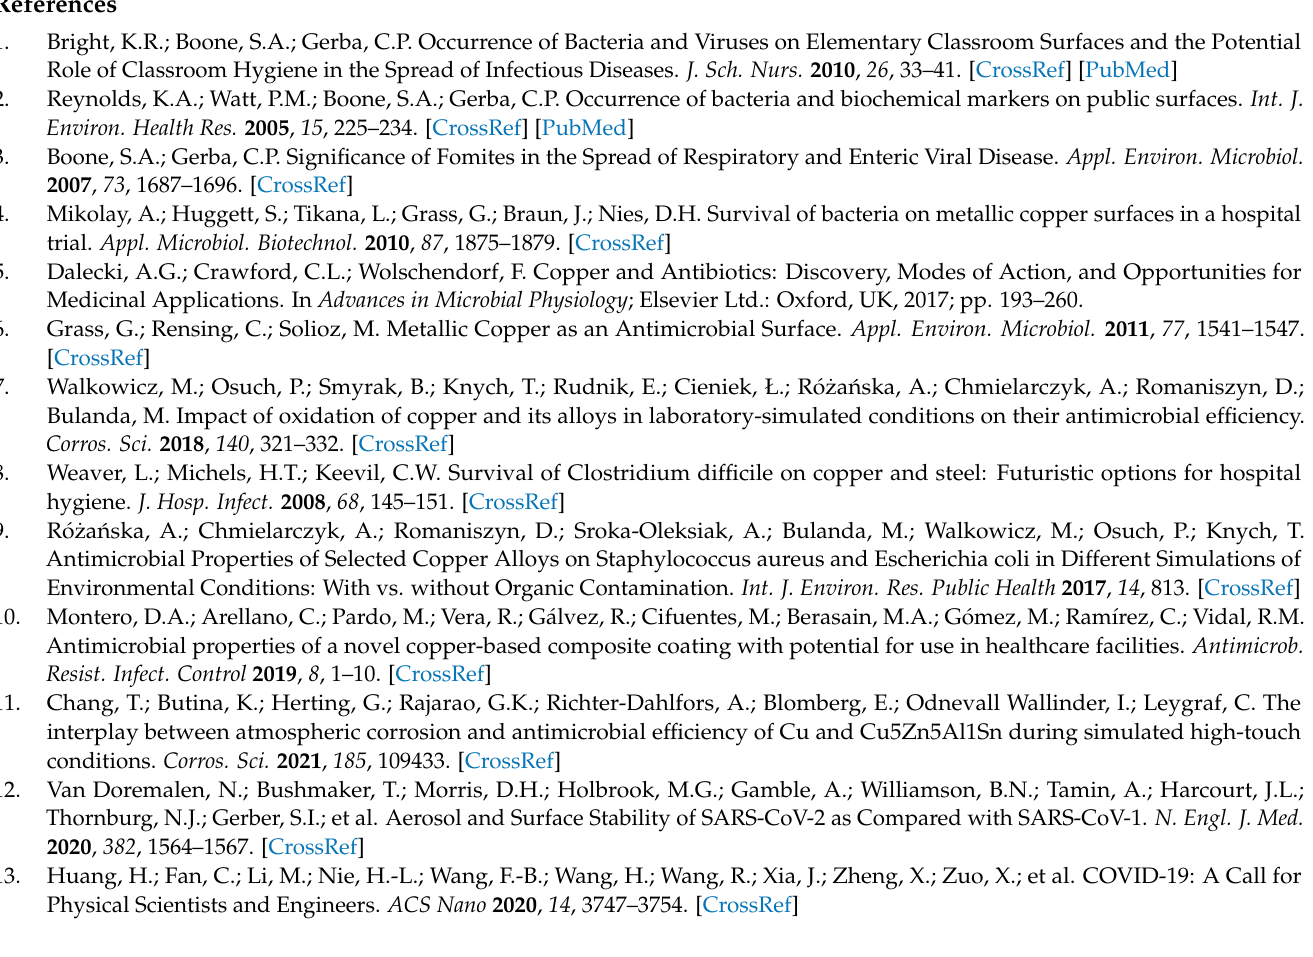
composite coating. The dashed line indicates the substrate (bottom) and the coating (top) border; Figure S2: EDX elemental distribution maps of Ti-0 (a) and Ti-5 (b) coatings after 168 h of corrosion experiments in 3% NaCl solution; Table S1: Luster and microhardness of Cu–Sn and Cu–Sn–TiO 2 coatings; Table S2: XPS surface chemical analysis of Cu–Sn and Cu–Sn–TiO 2 coatings; Table S3: Composition of bacteria